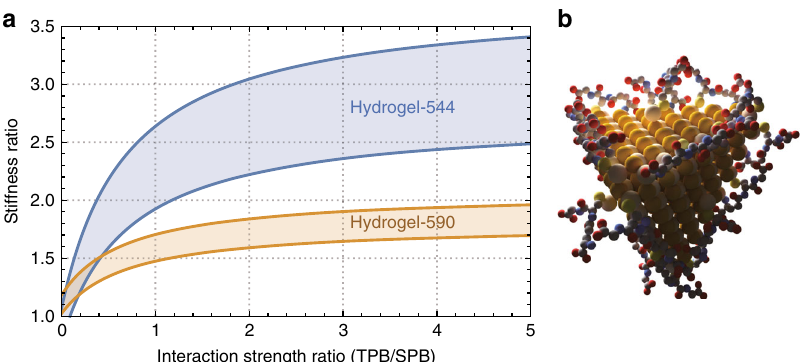
Fig. 4 Molecular origin of NP hydrogel mechanics. a Theoretical bounds for the stiffness of Hydrogel-544 (blue) and Hydrogel-590 (orange) compared to Hydrogel-618 as a function of the interaction strength ratio between TPB – GSH and SPB – GSH. If TPB-mediated interactions between NPs are twice as strong as SPB-mediated ones and mainly present in the edges (upper bound), a threefold increase in stiffness is expected for smaller CdTe hydrogels, b schematic representation of a 2.7 nm CdTe NP showing three-point bonds covering corners and edges and single-point bonds are covering the surfaces. Our models suggest that the higher stiffness in hydrogels from smaller NPs results from the relative higher number of three-point bonds. Note: GSH Colors follow legend in Fig. 3